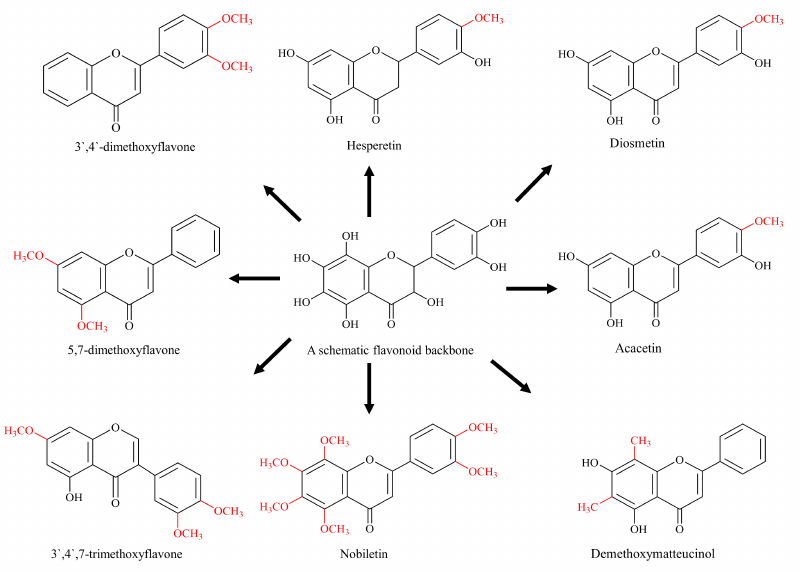
Figure 2. Diagrammatic representation of methylated flavonoids (schematic flavonoid is a hypotheti- cal compound used to show all hydroxyl positions accessible for